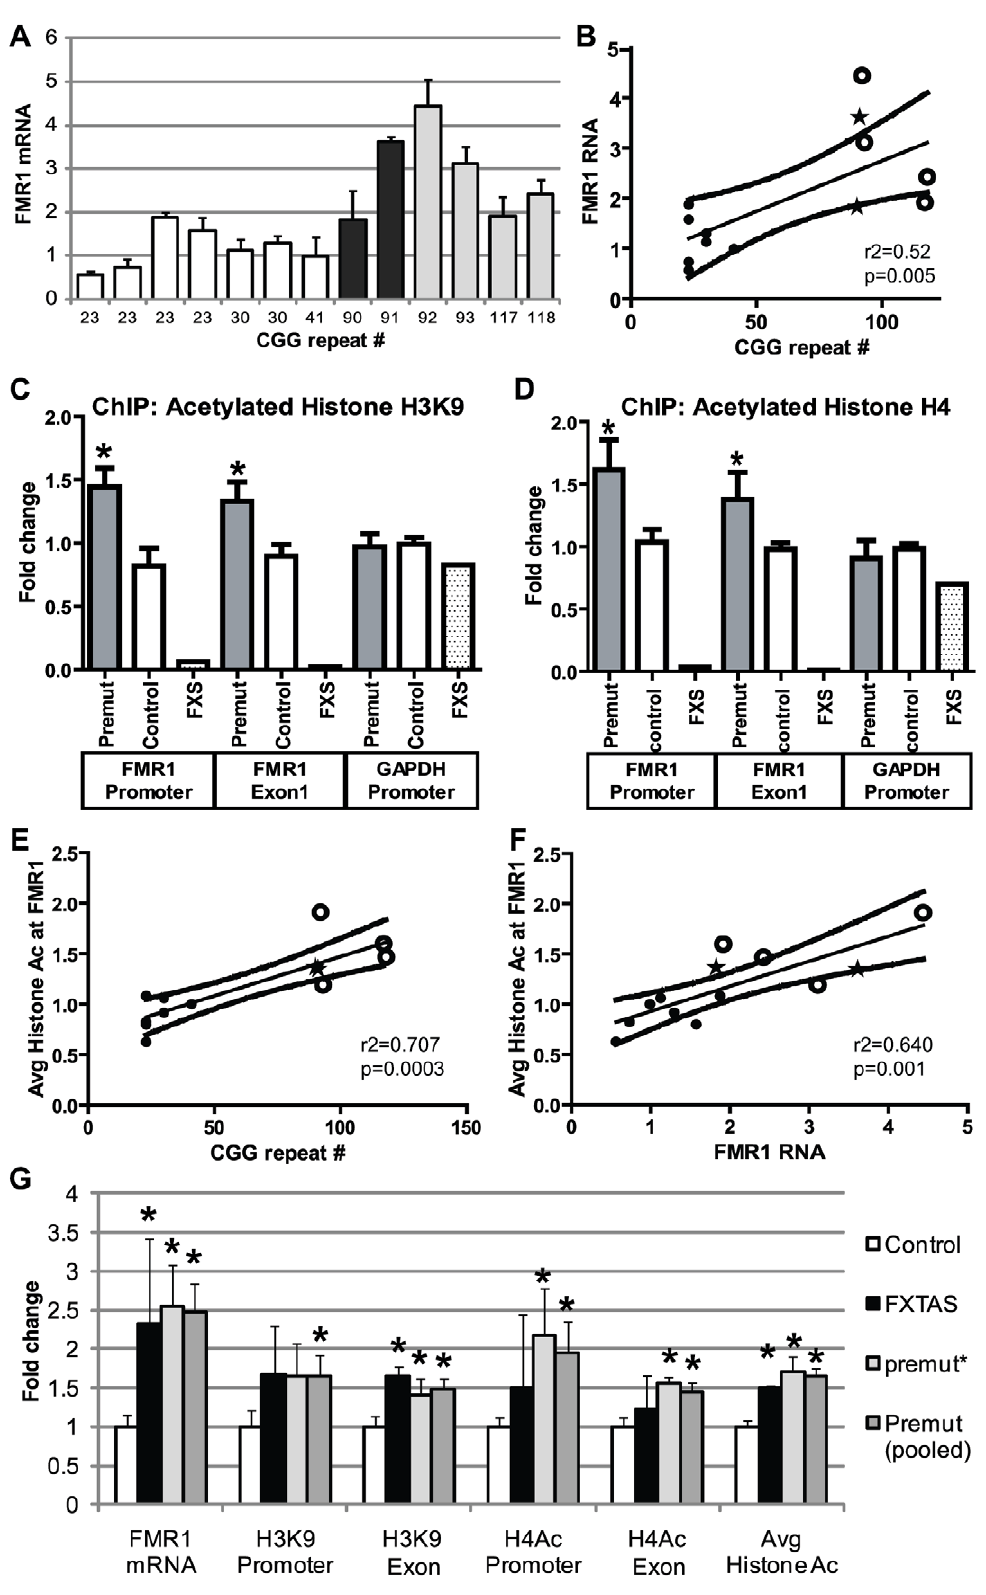
Figure 4. Chromatin alterations at FMR1 locus in pre-mutation expansion carrier lymphoblasts. A) FMR1 mRNA expression by qRT-PCR from 13 lymphoblastoid cell lines derived from male patients in fragile X families. FMR1 mRNA levels, normalized to actin mRNA, are expressed relative to a control cell line included in all experiments ((CGG) 41 ). White bars= control cell lines. Black bars= confirmed FXTAS cases. Light grey bars= pre-mutation carriers whose clinical status is unknown. B) Correlation between CGG repeat size and FMR1 mRNA. Solid black dots= control